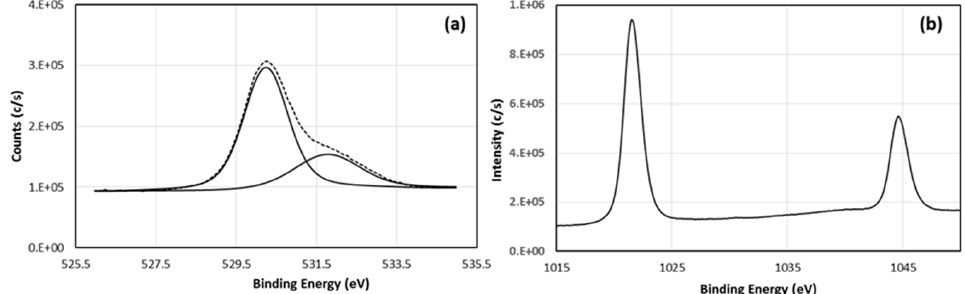
Figure 3. High resolution of XPS core level spectra of ( a ) O1s solid line: raw data, dotted line: fitting and ( b ) Zn2p.